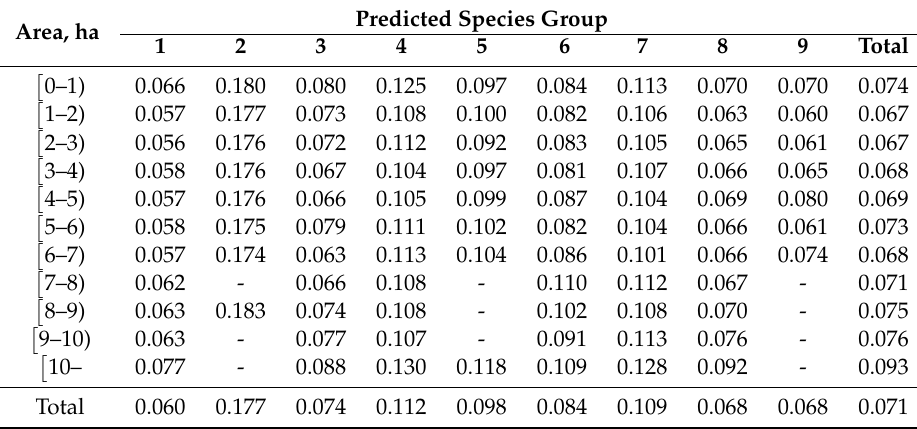
Figure 9. Distributions of the confidence intervals by the species groups, shown as boxplots, that is, median, 25% and 75% percentiles, 1.5 times of the interquartile ranges, and individual outliers. The width of the box is proportional to the square root of the number of the observations of the species group. Table 8. The averages of the widths of 95% confidence intervals of the probability predictions of the categories by the area classes (ha) and species